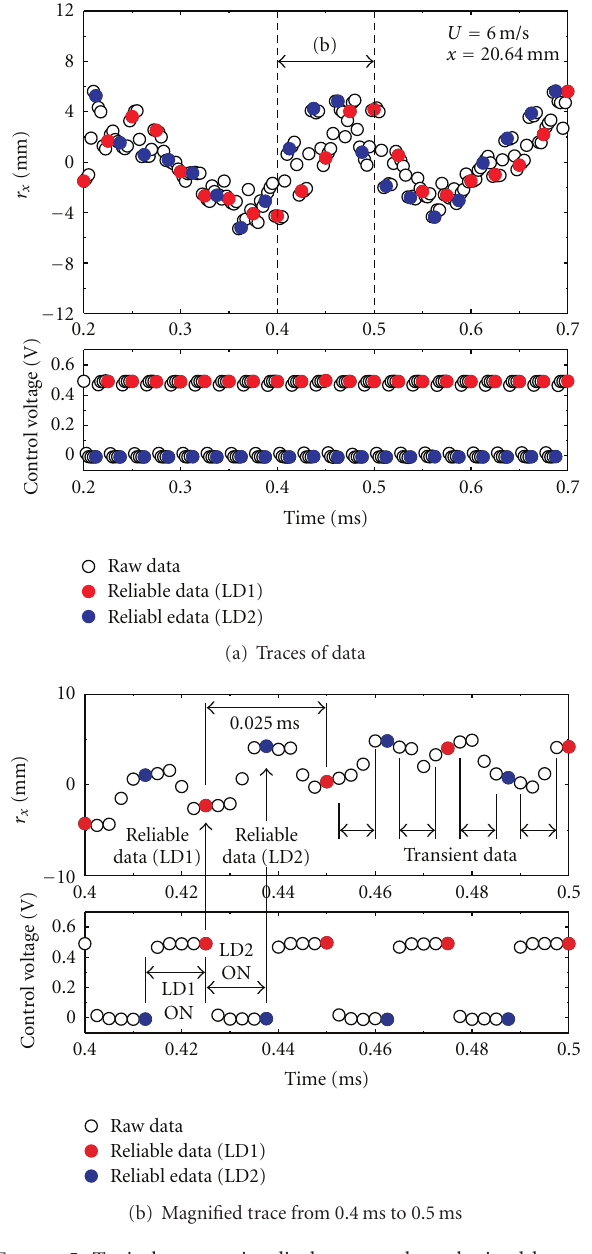
Figure 5: Typical streamwise displacement data obtained by two lasers.